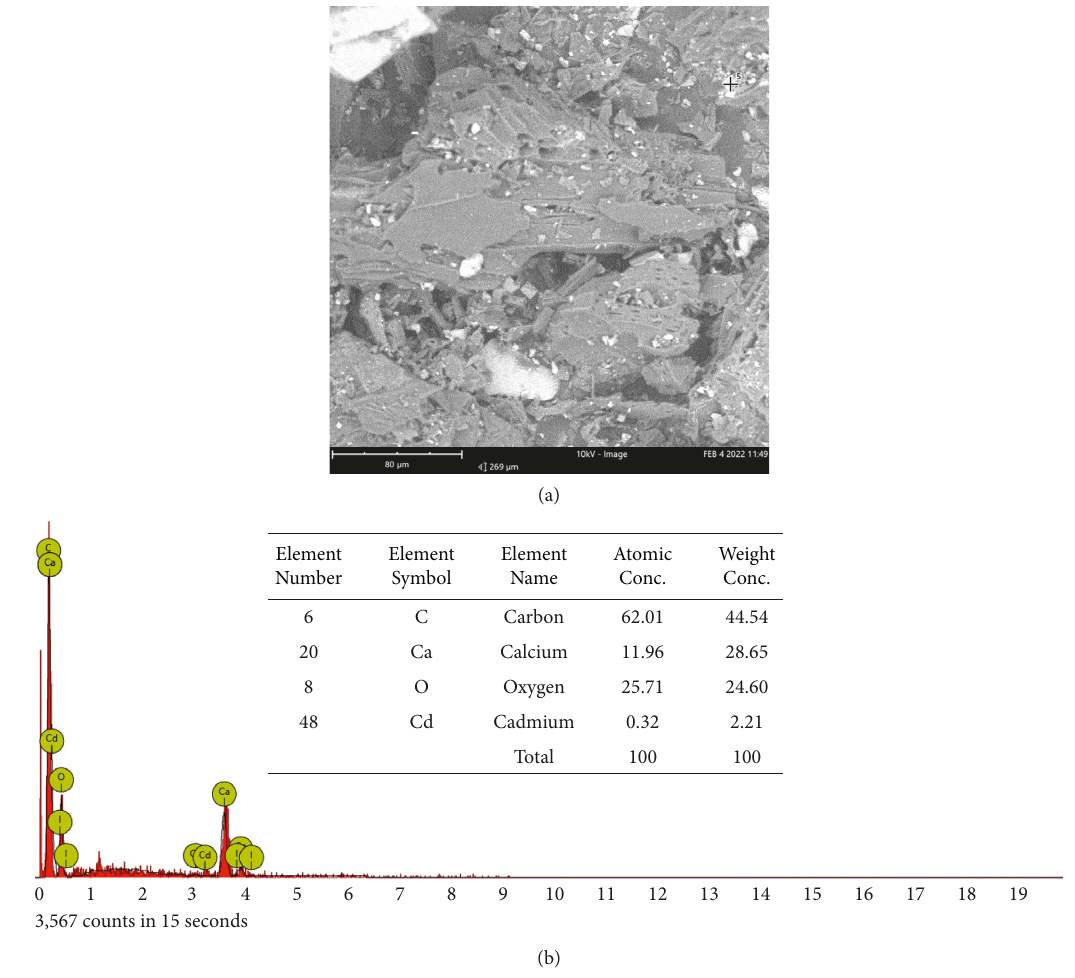
Figure 9: (a) BSED image of the BAC-Zn adsorbent before adsorption showing the spectrum used for EDX analysis. (b) The corresponding EDX spectrum at the spectrum point as indicated in